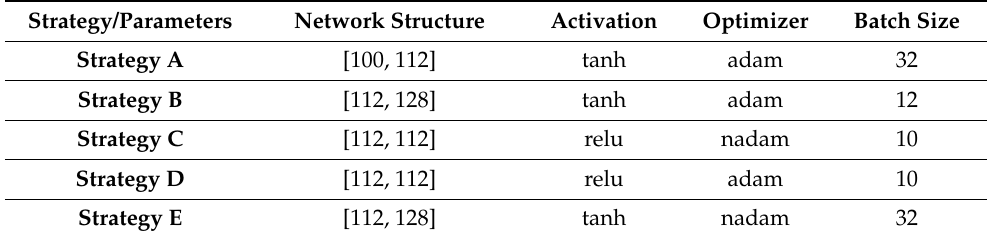
Table 4. Neural network structure of each